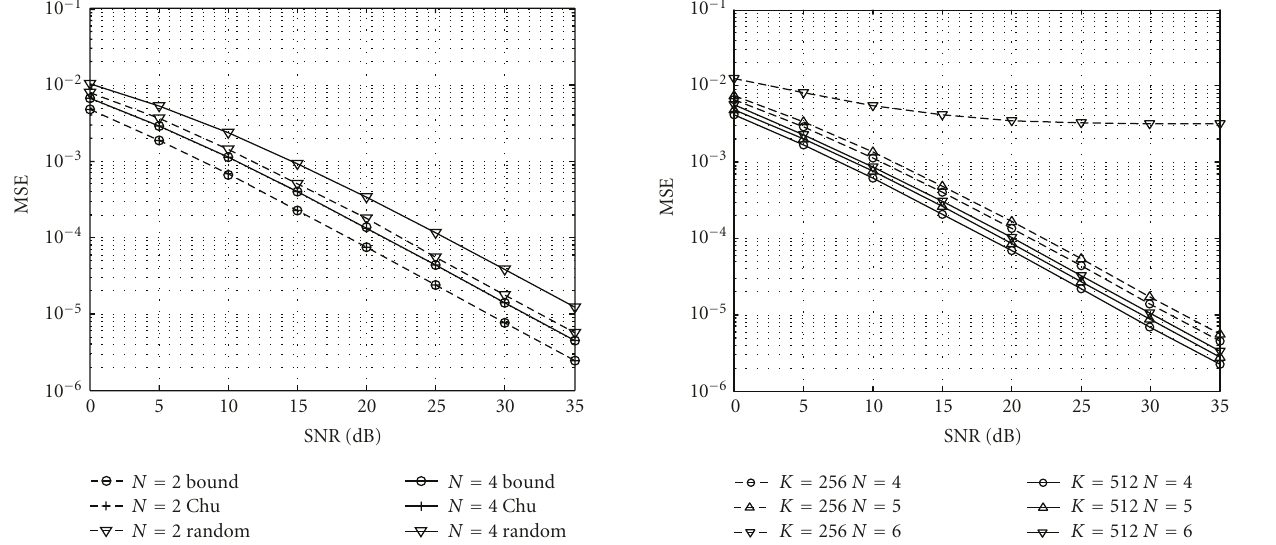
Figure 3: MSE performance comparison of the proposed channel estimation method using di ff erent training sequences.